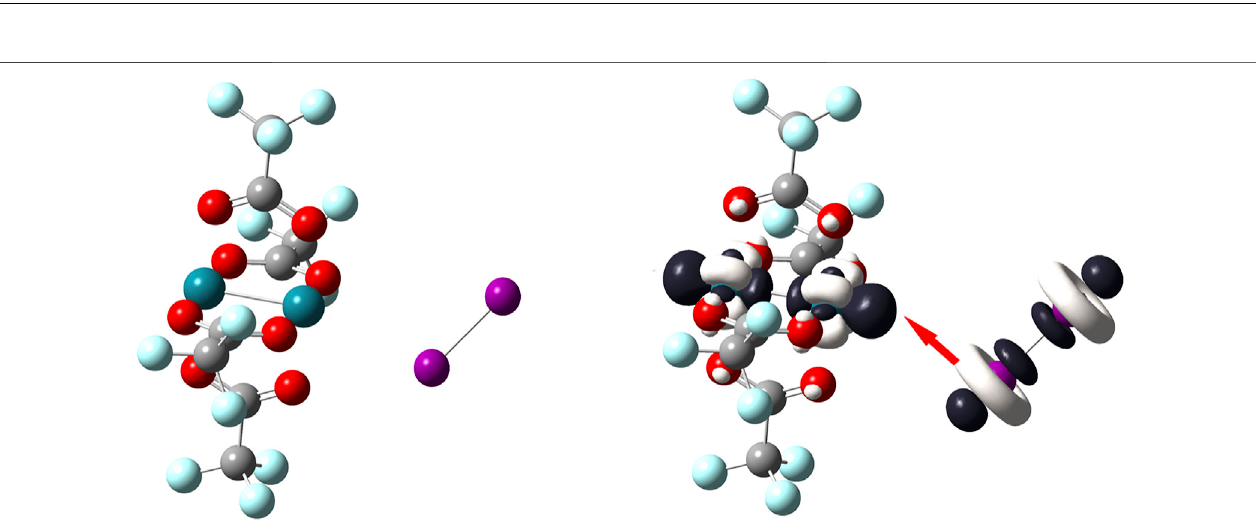
lobes surrounding iodine atoms are the nucleophilic